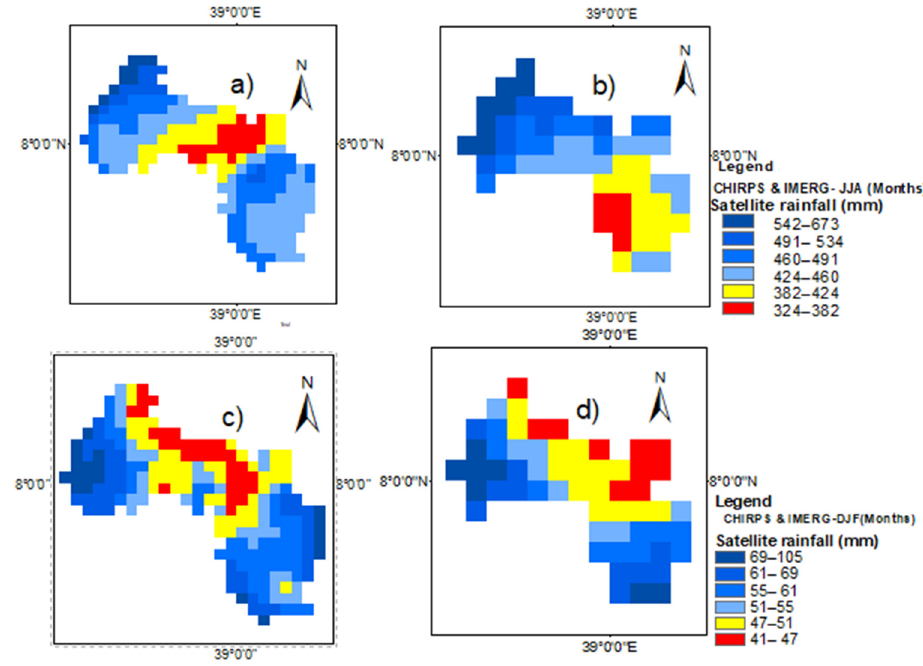
Figure 3. Spatial distribution of main rainy and dry season rainfall ( a , c ) for CHIRPS, ( b , d ) for IMERG for the period 2000–2014.